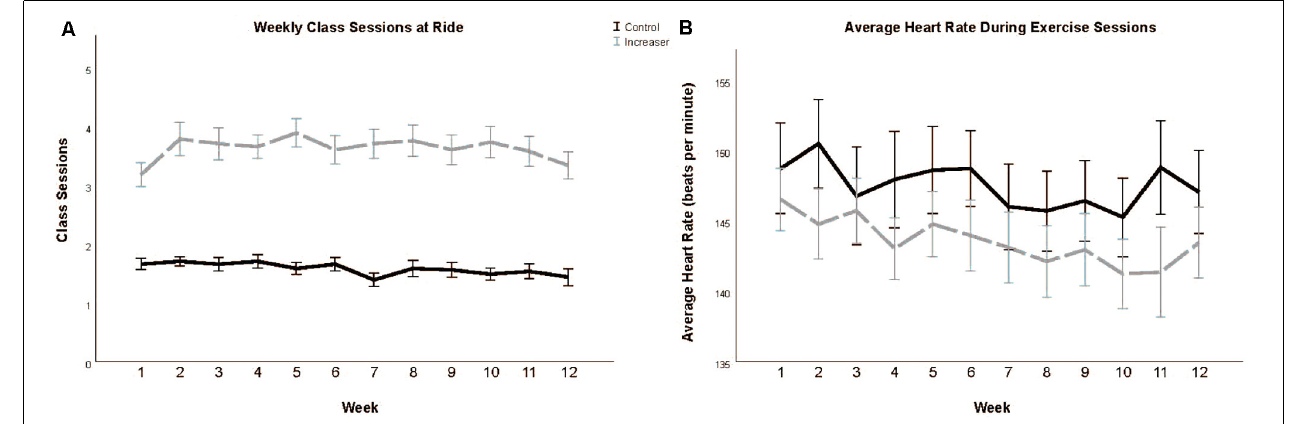
FIGURE 2 | Total class sessions (A) and average heart rate during class sessions (B) during the 12-week intervention period. Data presented as means and standard errors.